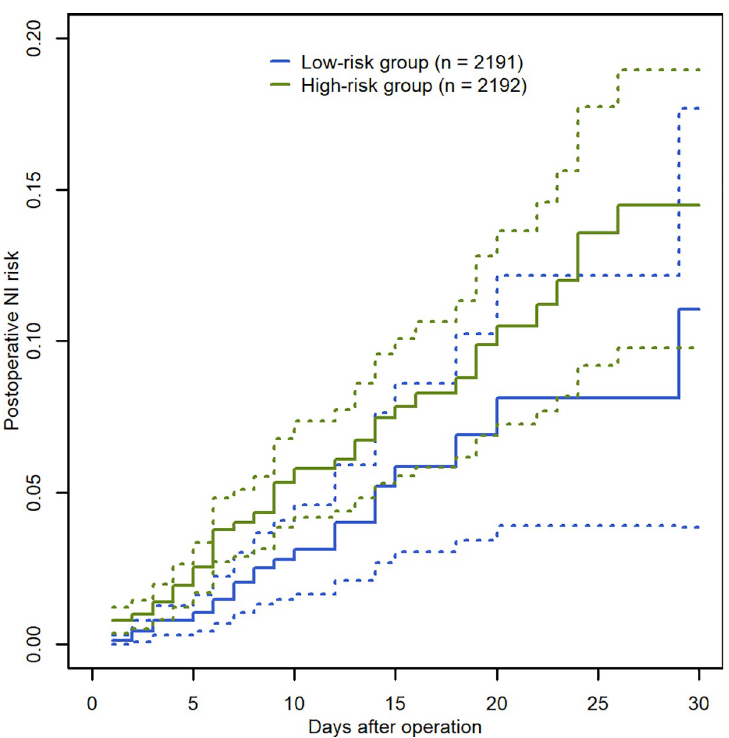
Fig 2. Postoperative NI risk in the low-risk group (2,192 patients including 21 NIs) and the high-risk group (2,191 patients including 79 NIs), stratified using the median of the risk score derived from the reduced AFT model a . a Analysis was done in an independent data set of patients undergoing invasive operation between January and May, 2019 (n = 4,383). NI (nosocomial infection).